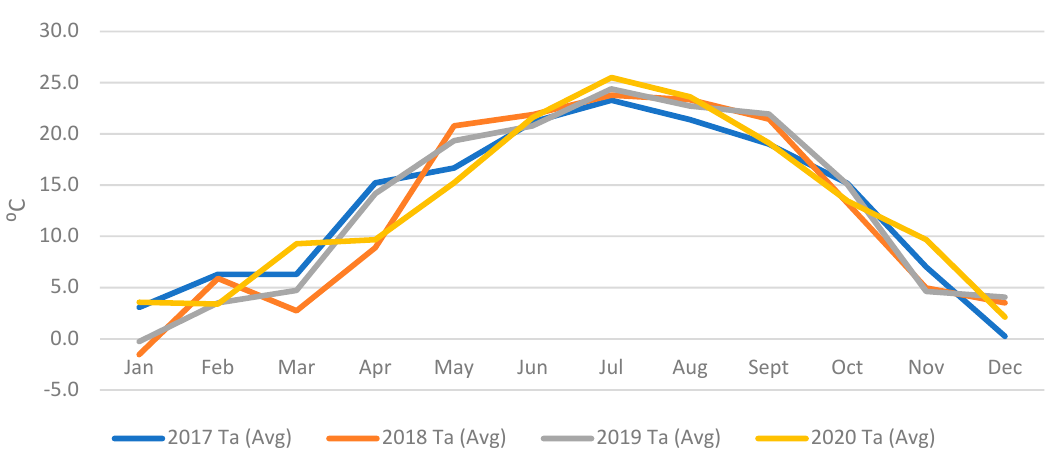
Figure 2. Monthly average temperature from 2017 to 2020 for Morgantown, West Virginia, USA, which is 22.5 km from the Ruby Run study site (NOAA 2022).